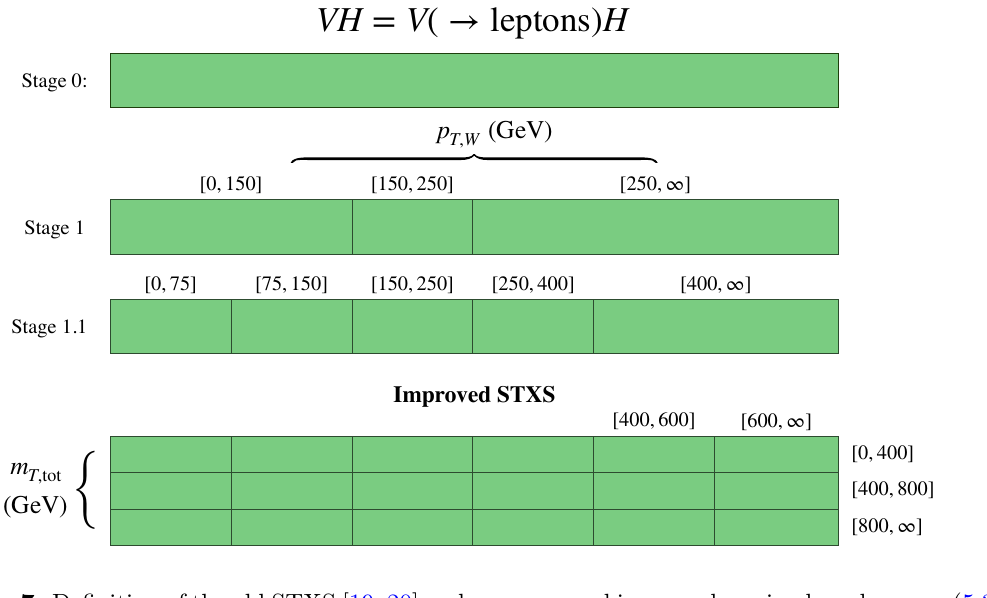
Figure 7 . De(cid:12)nition of the old STXS [19, 20] and our proposed improved version based on eqs. (5.3) and (5.4).